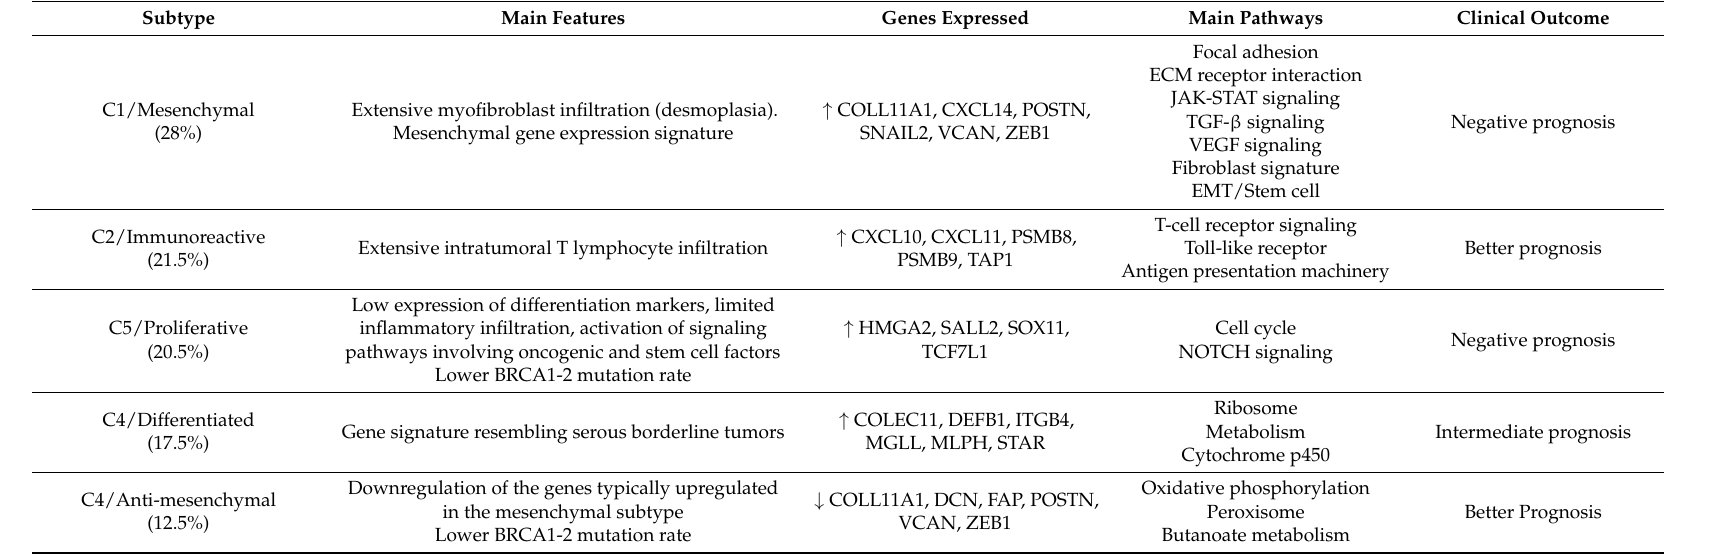
Table 3. Gene expression classification of